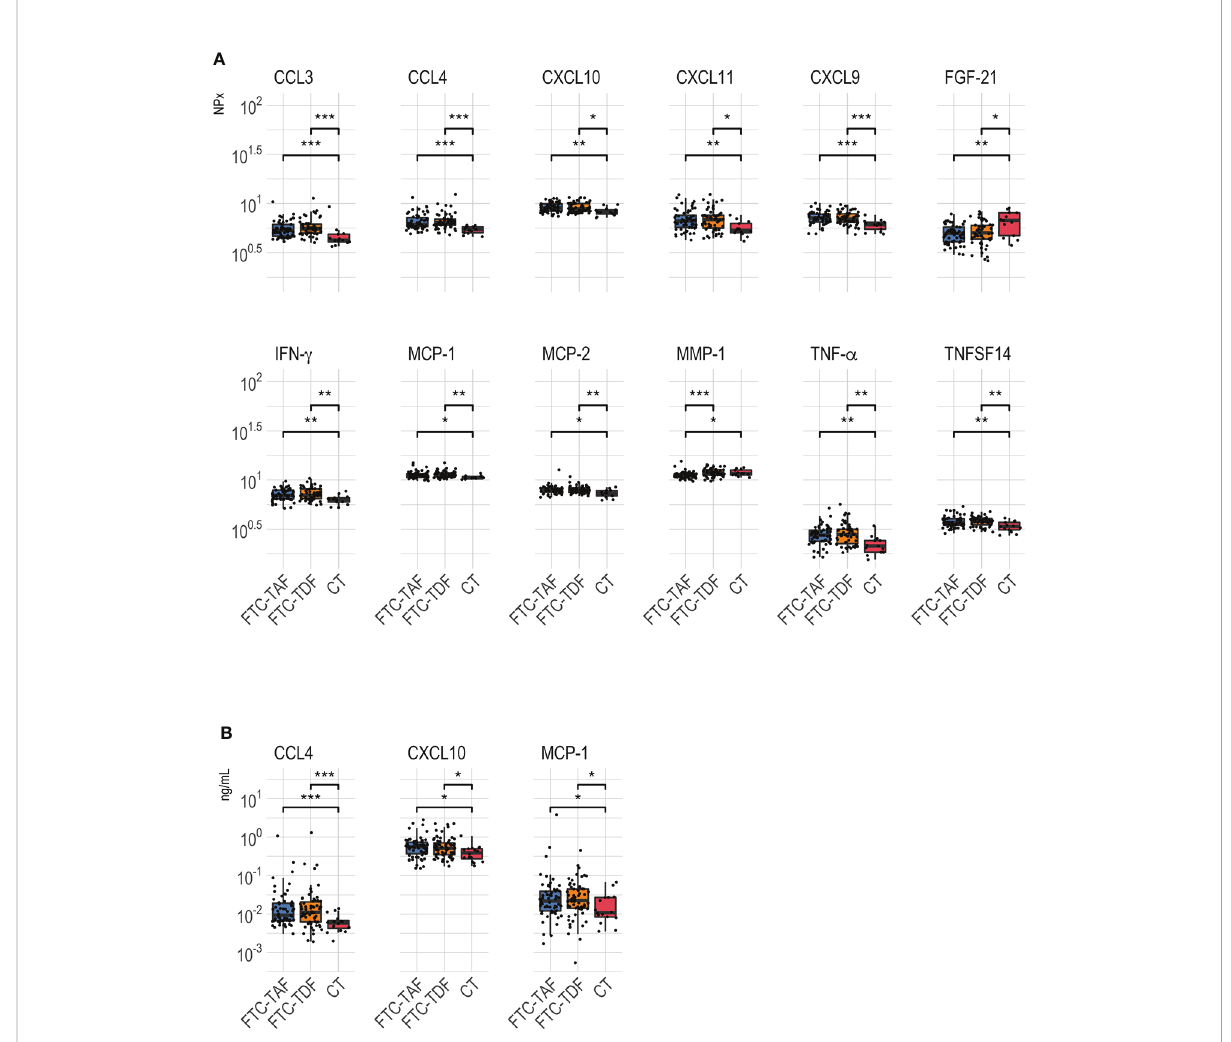
FIGURE 6 Abundance level of proteins identi fi ed as signi fi cantly different between arms receiving FTC-TDF or FTC-TAF. PrEP arms were merged by the type of administered drug and compared between each other and to controls. Analyses of data is shown in (A) for Olink and (B) for Luminex. Results were considered signi fi cant when p < 0.05 *p < 0.05; **p < 0.01; ***p <